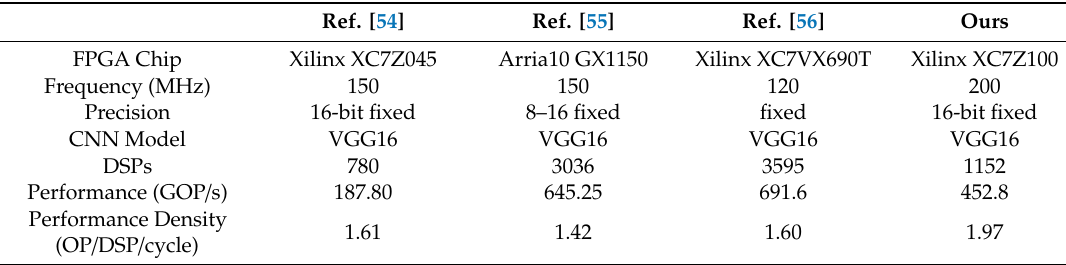
Table 5. Comparisons with previous implementations.